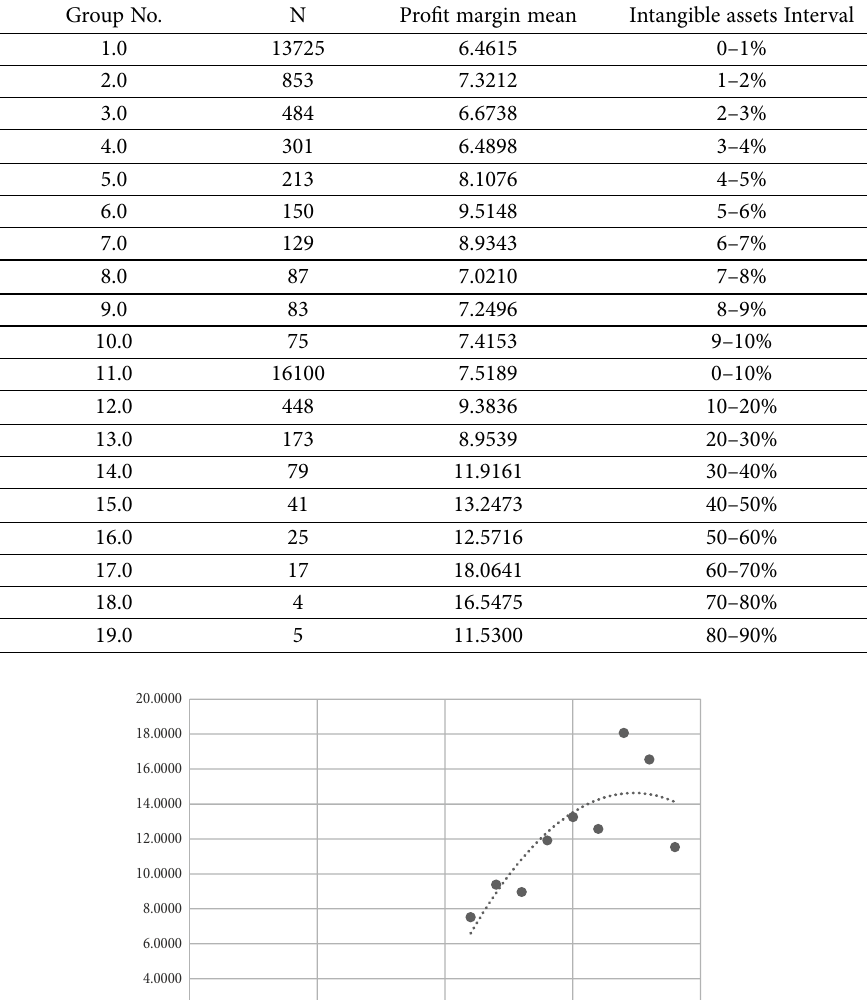
Table 5A. Profit margin mean analysis: average profit margin based on intangible assets intervals Group No.